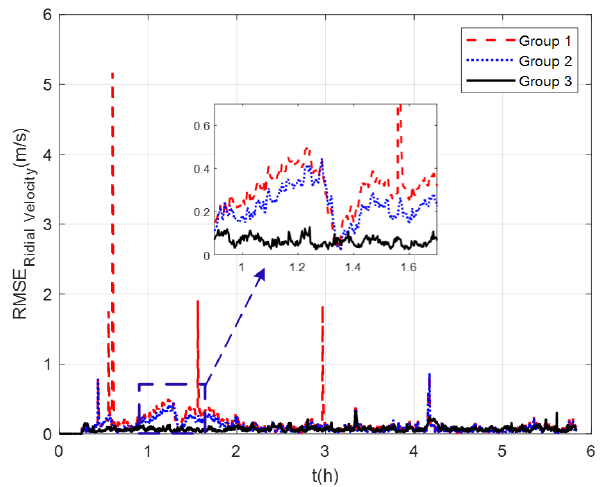
Figure 8. RSME of radial velocity at mid − latitudes.